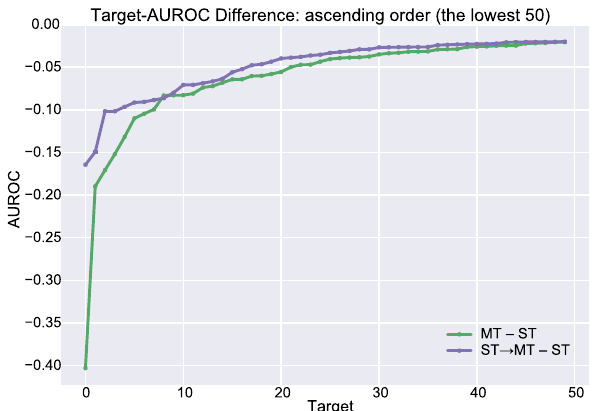
Figure 4. Target-AUROC difference from the single-task learning model. Targets are ordered in increasing order of AUROC difference. The targets with the lowest 50 AUROC differences are shown in this